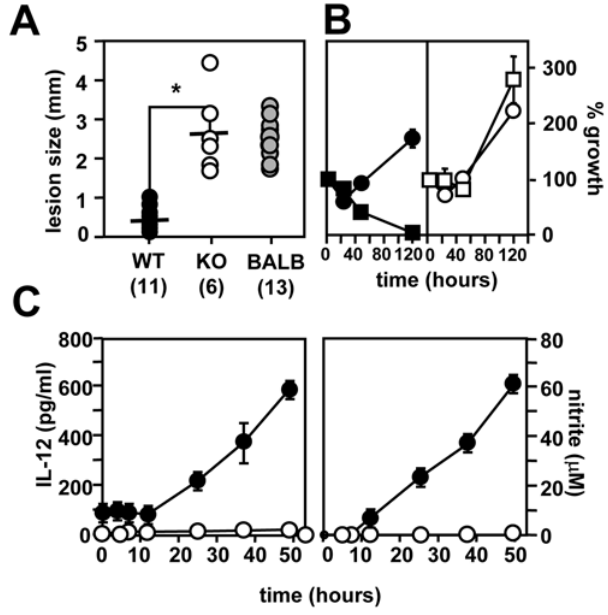
Figure 1. Stat1-deficient mice are susceptible to Leishmania infection. (A) Footpad analysis. 10 6 L. major promastigotes from stationary culture were inoculated subcutaneously into the hind footpad of SV129 control (closed circles), SV129 Stat1 2 / 2 (open circles), and susceptible BALB/c mice (gray circles), and lesion size was followed for 90 days post-infection. The graph represents the footpad swelling at day 70 post-infection after lesions resolved in the resistant SV129 controls (number of infected animals per group is shown in brackets). *, p=2e-6. (B) Macrophage infection. Stat1-deficient (open symbols) and SV129 wild-type PEMs (closed symbols) treated with 100 U/ml IFN c and 100 ng/ml LPS for 12 h (squares) and untreated controls (circles) were infected with complement-opsonized stationary promastigotes and the number of intracellular parasites per 100 macrophages was determined microscopically. Three independent experiments were performed and one representative triplicate exper- iment is shown. (C) Macrophage activation. 10 4 peritoneal exudate macrophages (PEM) of SV129 control (closed circles) and Stat1 2 / 2 (open circles) were seeded into micro-titer plates and treated with 100 U/ml IFN c and 100 ng/ml LPS. Levels of IL-12p70 (left panel) and nitrite (right panel) were determined in the supernatants at the time points indicated. The bars represent the standard deviation of one triplicate